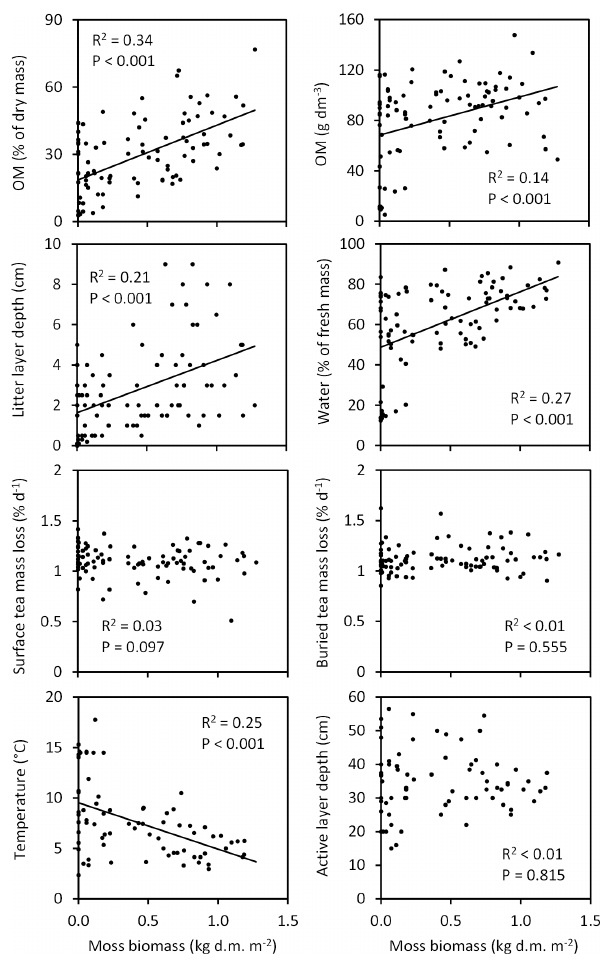
Figure 11. Associations of vascular plant leaf area index (LAI, mea- sured in late July with ca. 360 DD) with soil characteristics across the Tiksi tundra field plots (see Fig. 10 for an explanation of data and